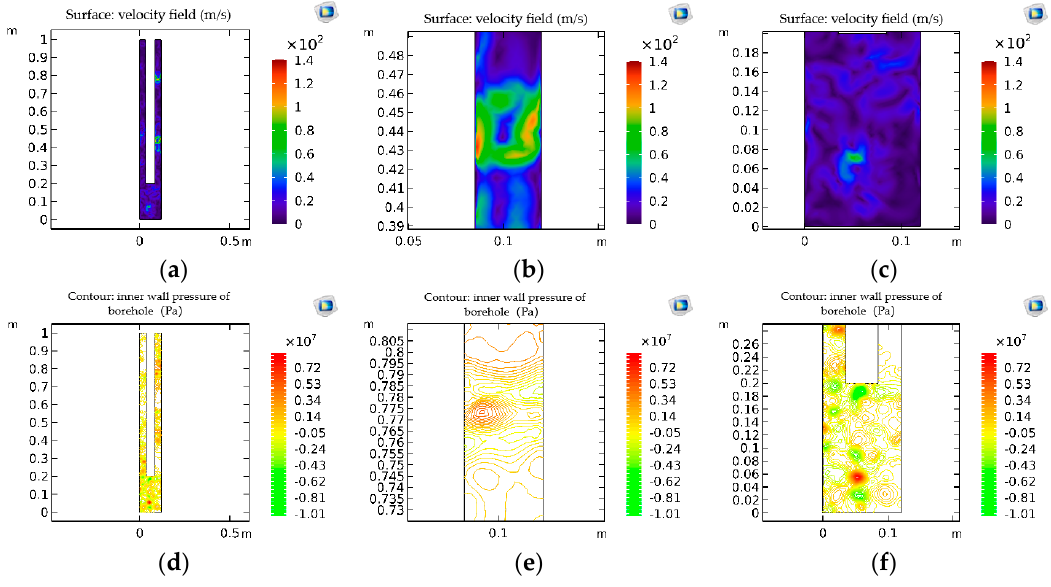
Figure 5. Fluid–solid coupling boundary state of 0.12 m borehole. ( a ) Surface velocity of inner wall of 0.12 m borehole. ( b ) Surface velocity of inner wall of 0.12 m borehole (velocity peak position 1). ( c ) Surface velocity of inner wall of 0.12 m borehole (velocity peak position 2). ( d ) Hole wall pressure of 0.12 m hole diameter. ( e ) Hole wall pressure of 0.12 m hole diameter (stress peak position 1). ( f ) Hole wall pressure of 0.12 m hole diameter (stress peak position 2).